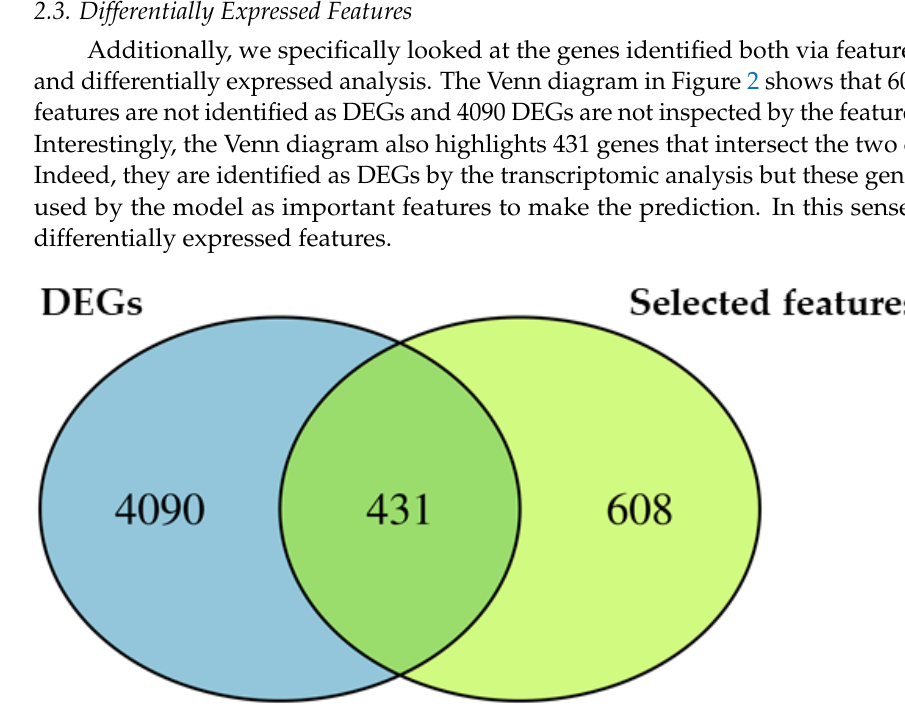
Table 3. Gene ontologies enriched for the DEGs included as selected features.